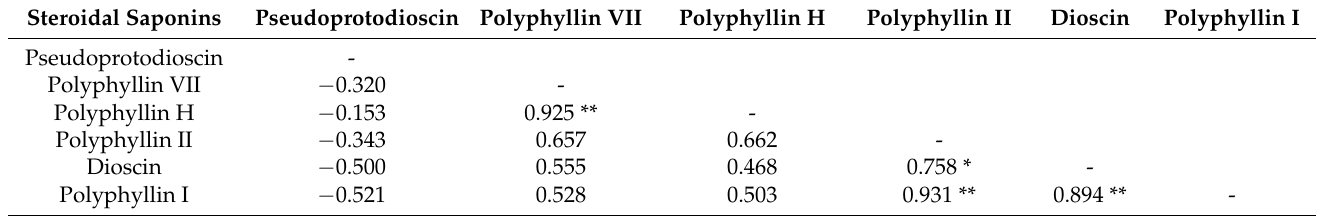
Correlation Analysis of Six Steroidal Saponins in the rhizome of Paris polyphylla var. yunnanensis